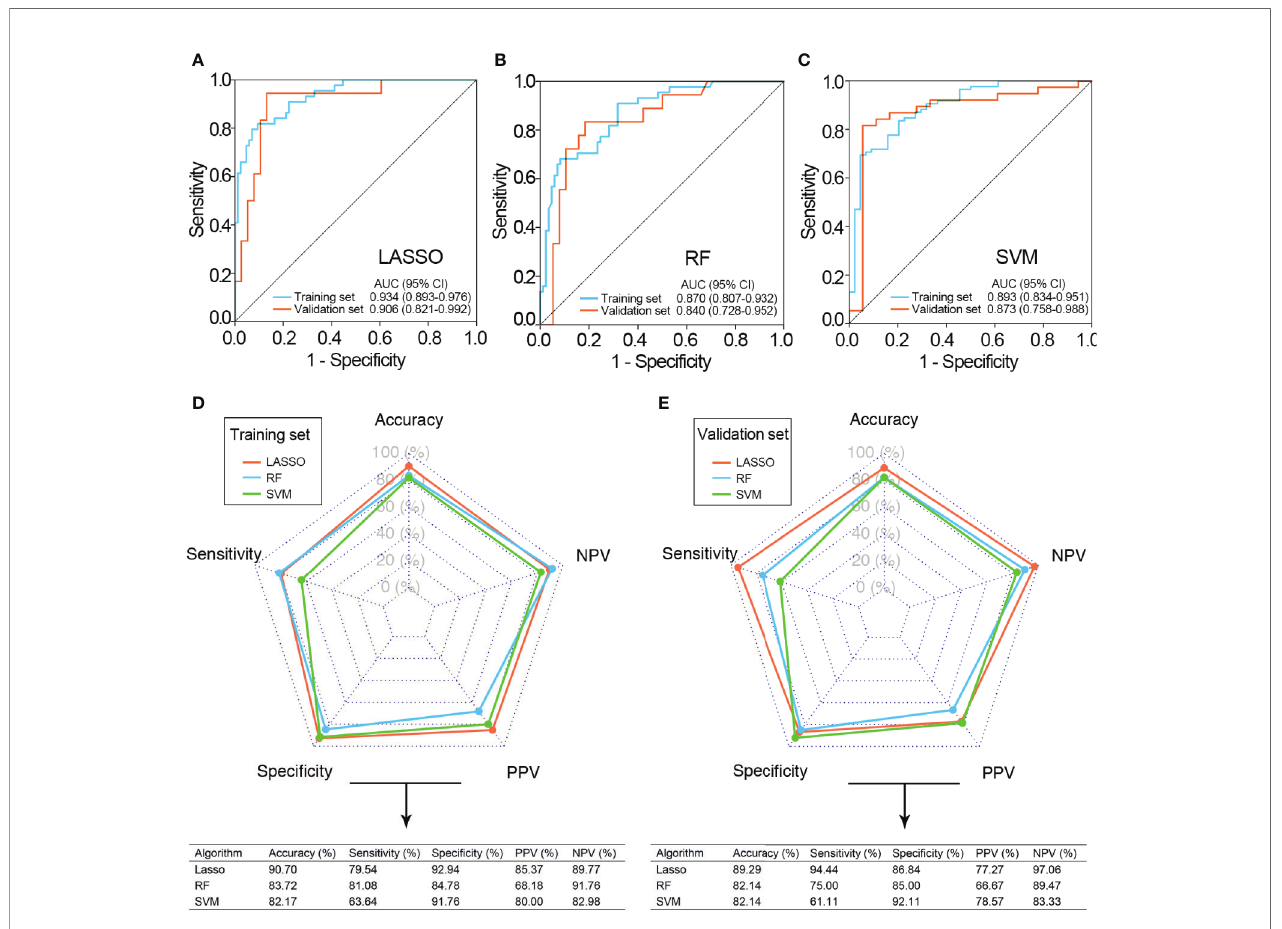
FIGURE 4 | Performance of three classi fi ers for the preoperative differentiation of muscle-invasive status. ROC curves of LASSO (A) , RF (B) , and SVM classi fi ers (C) in the training and validation sets. The predictive performance of the three classi fi ers in the training (D) and validation sets (E) . CI, con fi dence interval; ROC, receiver operating curve; AUC, area under the ROC curve; LASSO, least absolute shrinkage and selection operator; RF, random forest; SVM, support vector machine; NPV, negative predictive value; PPV, positive predict